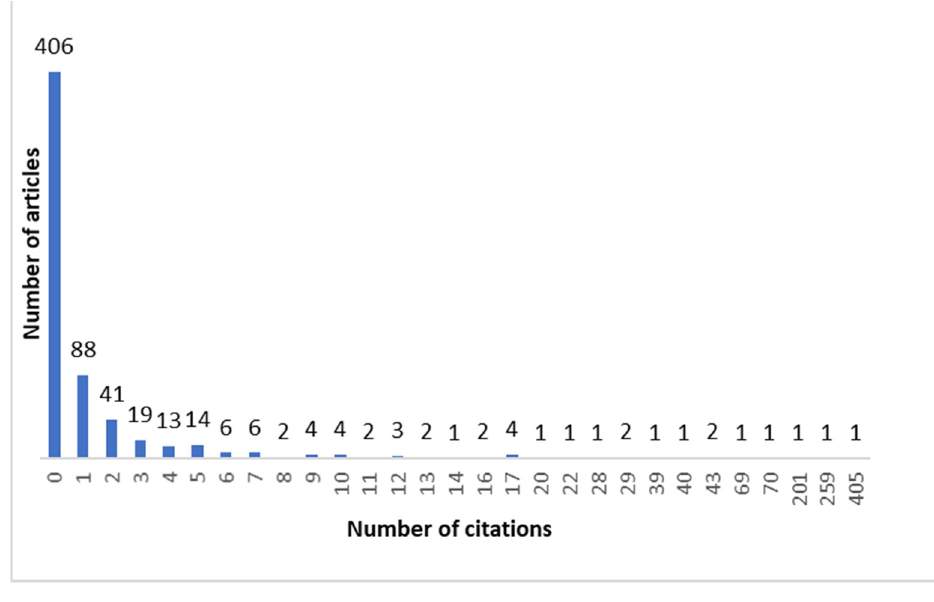
Figure 3. Frequency of PubMed citations.